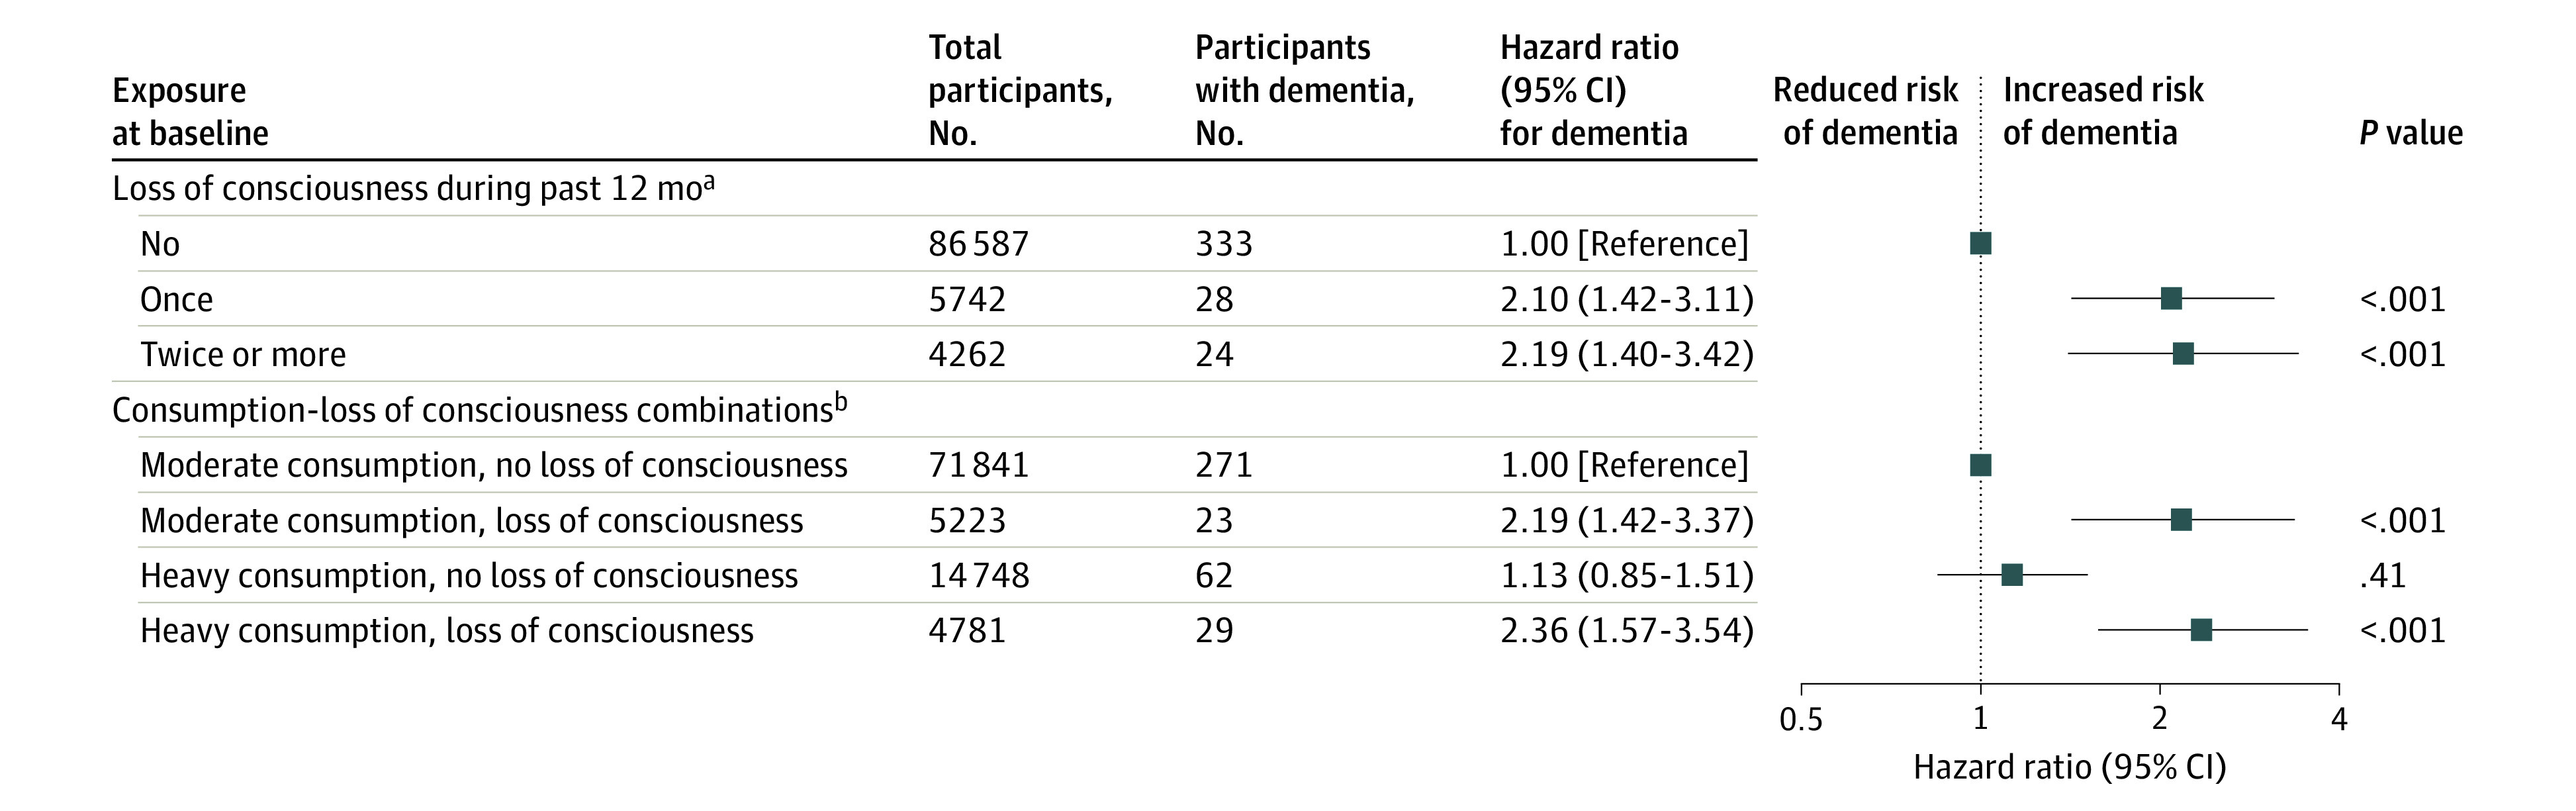
Association Between Alcohol Consumption and Loss of Consciousness Combinations With Incident DementiaaHazard ratio was adjusted for age, sex, educational level, occupational position, overall alcohol consumption, and cohort.bHazard ratio was adjusted for age, sex, educational level, occupational position, and cohort.